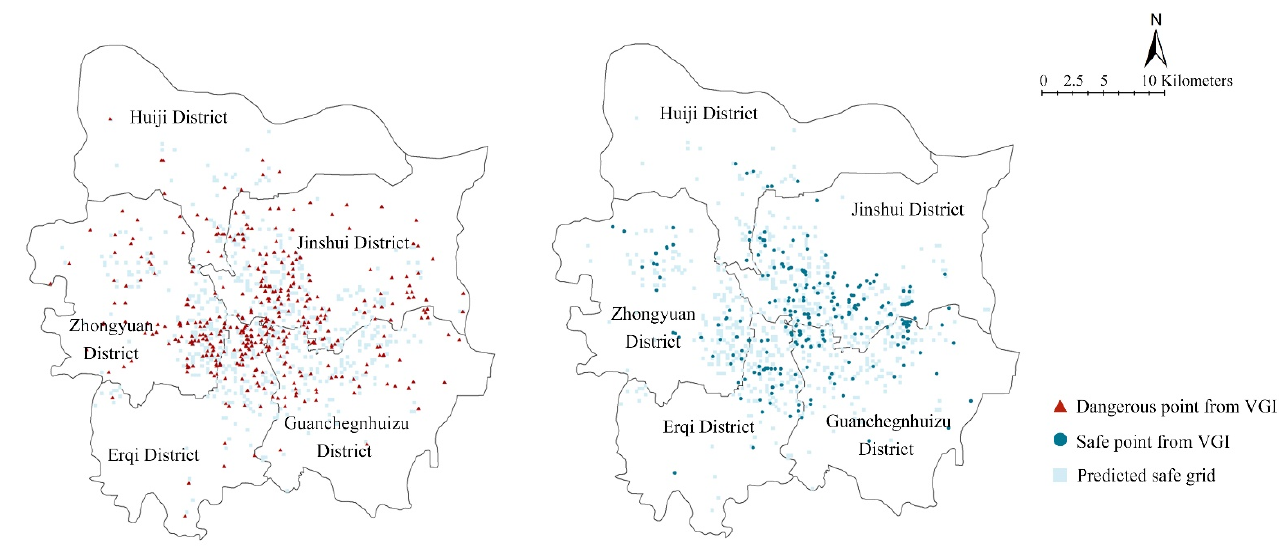
Figure 9. Comparison of predicted safe grids and the dangerous/safe points from volunteered geographic information(VGI). Table 5. Comparison of predicted results and actual data.